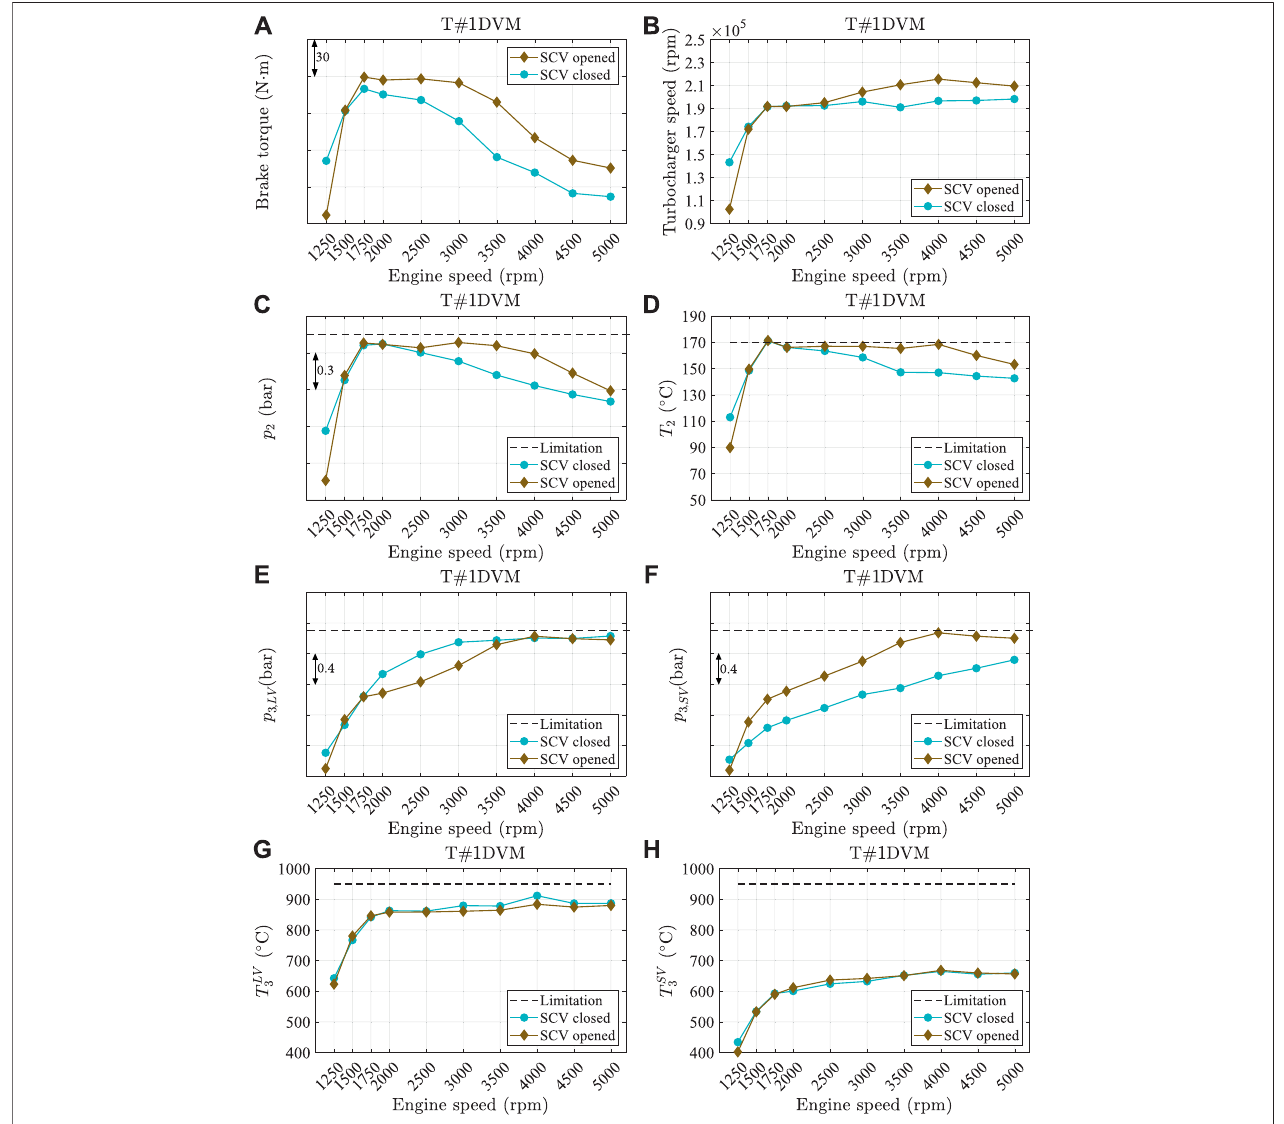
FIGURE 6 | Dual volute mixed fl ow turbine engine test results at full load steady conditions. (A) Engine brake torque; (B) turbocharger speed; (C) manifold inlet pressure; (D) manifold inlet temperature; (E) turbine inlet pressure in long volute; (F) turbine inlet pressure in short volute; (G) turbine inlet temperature in long volute; (H) turbine inlet temperature in short